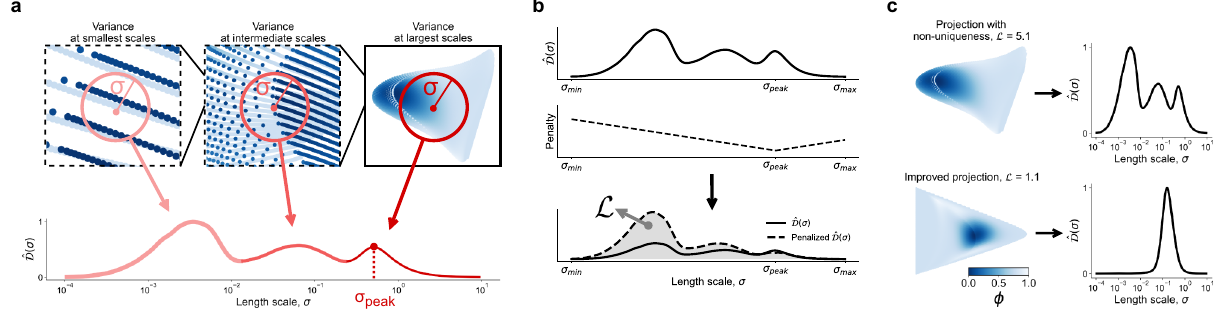
Figure 2. The proposed cost function, L , distills information about variance in dependent variable’s values occurring at different length scales, σ , on a manifold. ( a ) Manifold is first scanned at different values of σ for any variation in the dependent variable’s values. Multiple scales of variation manifest themselves in multiple peaks seen in the constructed normalized variance derivative curve, ˆ D (σ) . The location of the rightmost peak, σ peak , denotes the largest feature size on a manifold. Variance occurring at scales σ ≪ σ peak is a strong indicator of non-uniqueness. ( b ) The cost function, L , is computed by integrating the penalized ˆ D (σ) curve. The introduced penalty amplifies the area under ˆ D (σ) occurring at σ < σ peak and especially at σ ≪ σ peak . The contributions from all scales of variation are thus summed up and embedded in the cost value. ( c ) Assessing example 2D projections with the proposed cost function. The first projection exhibits non-uniqueness, with regions where smallest and highest values of the dependent variable, φ , overlap each other. The non-uniqueness is significantly reduced on the improved projection and the corresponding ˆ D (σ) curve exhibits a single rise indicating a single feature size over the whole manifold. We show the associated costs for the two projections, with the cost for the projection with non-uniqueness being indicate feature sizes. Each scale at which a dependent variable shows variation over the manifold, including variation due to non-uniqueness, will create its own imprint in ˆ D (σ) . The largest spatial scale at which the dependent variable exhibits variation (the largest feature size) on a manifold is reflected in the rightmost peak location in the ˆ D (σ) profile, and we define it as σ peak (see Fig. 2a). In the “Methods” section, we present a more detailed discussion of how σ peak is obtained. Any smaller feature sizes appear as additional peaks for σ < σ peak . The 2D projection seen in Fig. 2a exhibits severe non-uniqueness which manifests itself in variance occurring at very small scales, σ ≪ σ peak . Two particularly appealing characteristics of the normalized variance derivative are taken into account for the design of our cost function. First, the locations of peaks in the ˆ D (σ) curve convey feature sizes on manifolds. With an appropriate penalty with respect to the largest feature size, σ peak , we favor manifolds that maintain large feature sizes, as those should facilitate modeling. Second, with multiple scales of variation present on manifolds, the area under the ˆ D (σ) curve will increase due to the additional peak(s) for σ < σ peak . The cost function proposed herein, L = L (ηηη , φφφ) , is computed from a penalized area under the ˆ D (σ) curve(s). By integrating the penalized ˆ D (σ) curve(s), we sum over the effects that multiple scales of variation have on the ˆ D (σ) profile. A visualiza- tion of the penalty function and its effect on the ˆ D (σ) curve for the manifold introduced in Fig. 2a is shown in Fig. 2b. We see how the area under ˆ D (σ) weighted by the penalty function is amplified at scales far from σ peak , therefore penalizing the variance occurring at smaller scales more heavily. Furthermore, the cost function gives a single number representing the parameterization “cost” for a given manifold. A larger cost indicates a worse manifold topology and a lower cost indicates an improved manifold topology in terms of modeling. If the cost is computed for m dependent variables, a norm over all L i costs can be taken to yield a single cost value for the entire manifold: L = || L i || , ∀ i ∈ [ 1, 2, . . . , m ] . Figure 2c demonstrates costs computed for a single dependent variable, φ , over two different 2D projections. The first projection is the same as analyzed in Fig. 2a. The second projection has an improved topology and non-uniqueness is significantly reduced. The corresponding ˆ D (σ) curve for the improved projection exhibits a single dominant peak which indicates a single scale of variation in φ values over the entire manifold. We report the cost, L = L φ , for each projection, with the cost for the projection with non-uniqueness being greater. The mathematical description of the proposed cost function and additional details are provided in the “Methods” section. There are three key advantages of our proposed cost function. First, manifolds obtained using any technique can be assessed. This includes any ad hoc selected manifold parameters or empirical manifolds obtained directly from training data using dimensionality reduction or manifold learning techniques. Second, manifolds of any dimensionality can be assessed. Finally, manifolds can be assessed with respect to an arbitrary set of m relevant dependent variables, φφφ . Dependent variables that we are most interested in accurately modeling can be selected, which can include any of the original state variables and any functions of them.